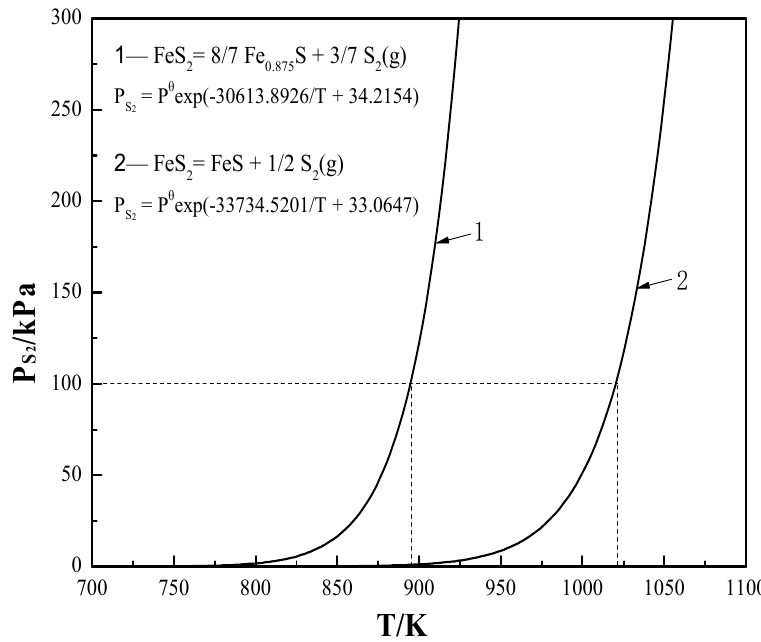
Figure 2. Relationship of P S2 and T during the pyrolysis of pyrite.